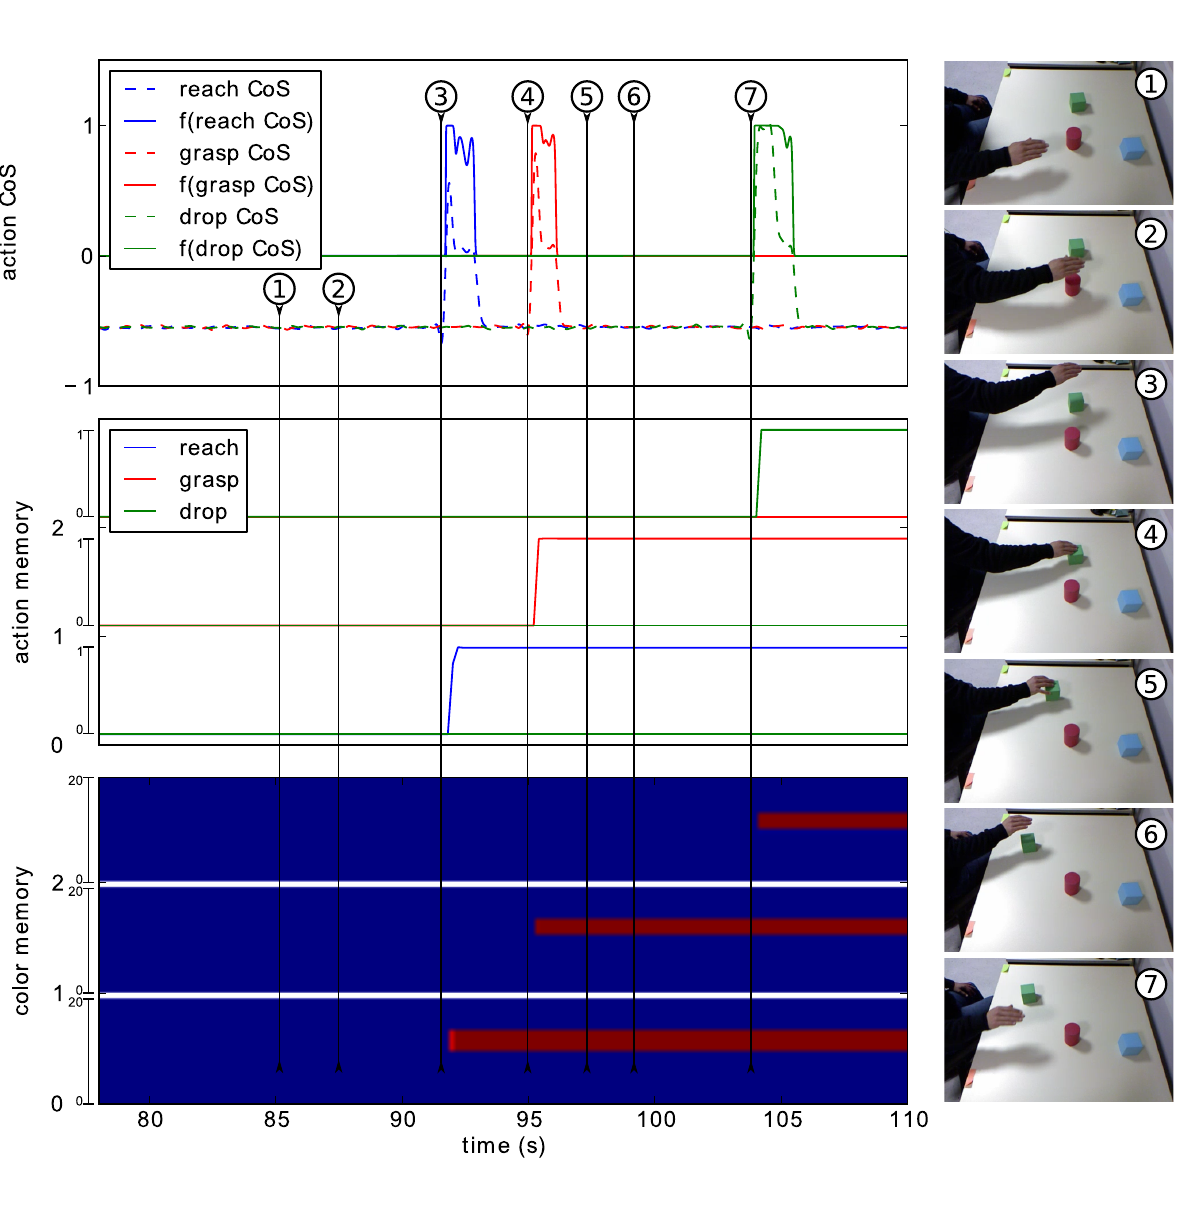
Figure 7: Time courses of the action detectors (top left) and contents of the action memory system (middle and bottom left) for the same demonstration as shown in Figure 6. See text for